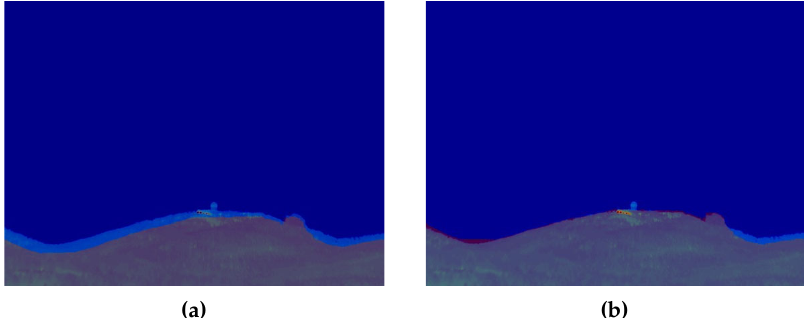
Figure 12. Effectiveness of the terrain profile alignment process. ( a ) Before terrain profile alignment.